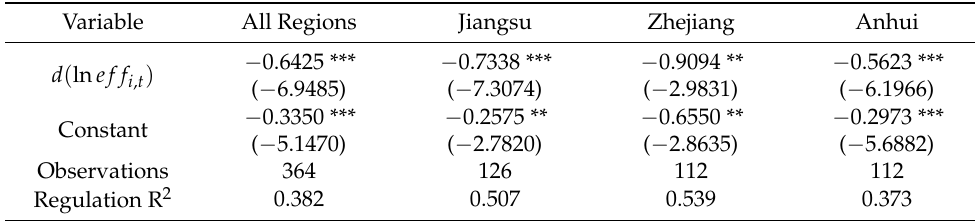
Table 6. Condition β Convergent Regression Results of Each